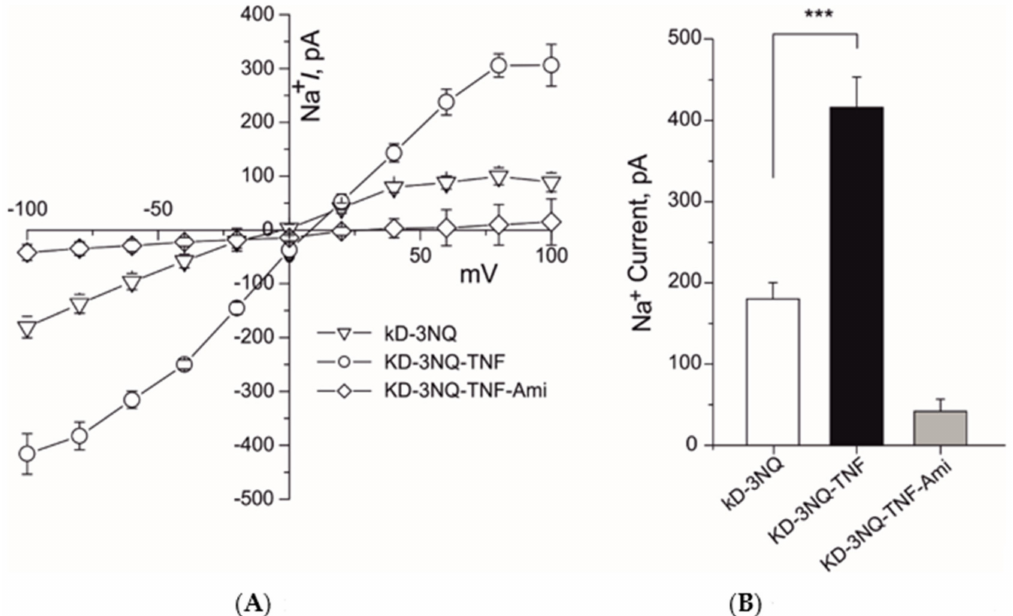
Figure 4. Overexpression of N-linked glycosylation sites mutated δ -ENaC (3NQ) restored the TNF mediated activation of ENaC in δ -ENaC KD A549 cells. ( A ) IV plots of whole-cell (10 µ M) amiloride-sensitive ENaC currents of indicated experi- mental settings are shown. ( B ) Mean values of whole-cell inward sodium currents at − 100 mV of indicated experimental settings are shown. Significant differences are indicated, *** p < 0.001, unpaired Student’s t -test, n =